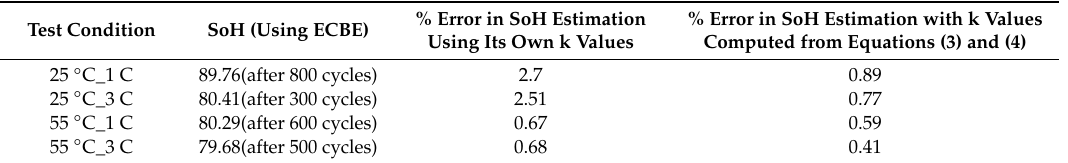
Table 10. Comparison of the % errors in SoH estimation.